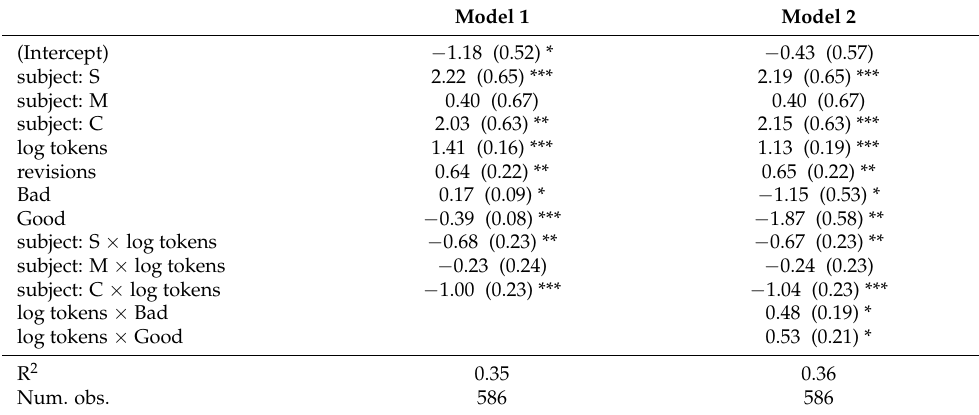
Figure 6. Differences between condition, averaging over covariates and interactions. Confidence intervals are simultaneous and corrected for multiple comparison using Tukey’s method. Table 9. Models for post-editing time (in log seconds). Model 2 allows advice quality to have different effects on translation time depending on target sentence